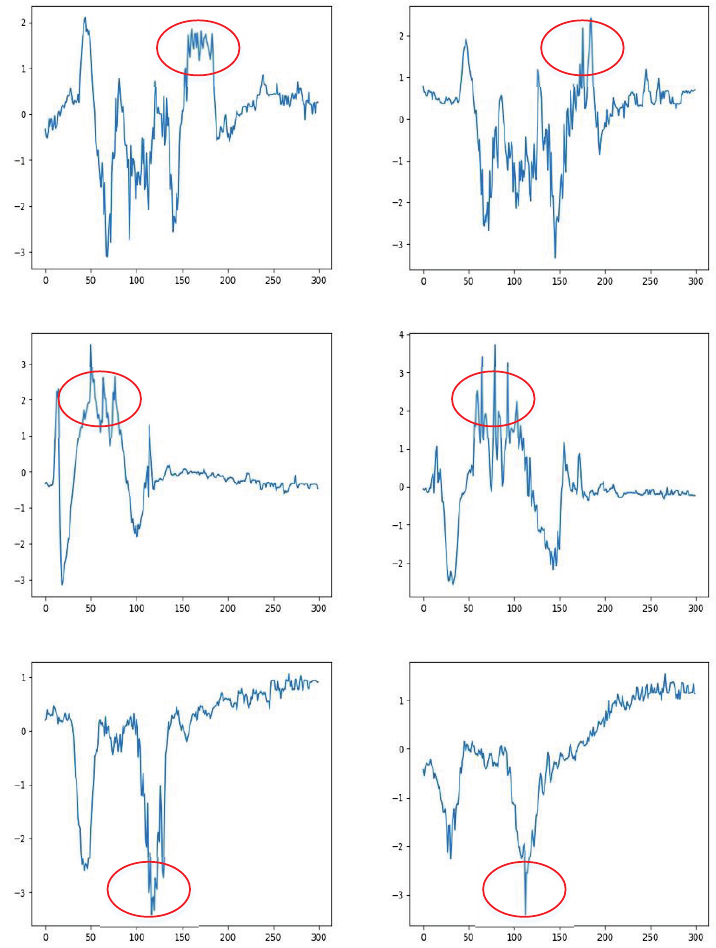
Figure 10. The training samples from the “CricketX”, “CricketY” and “CricketZ”. The samples from the same class are listed in the same row. High frequency noise could be observed in the red